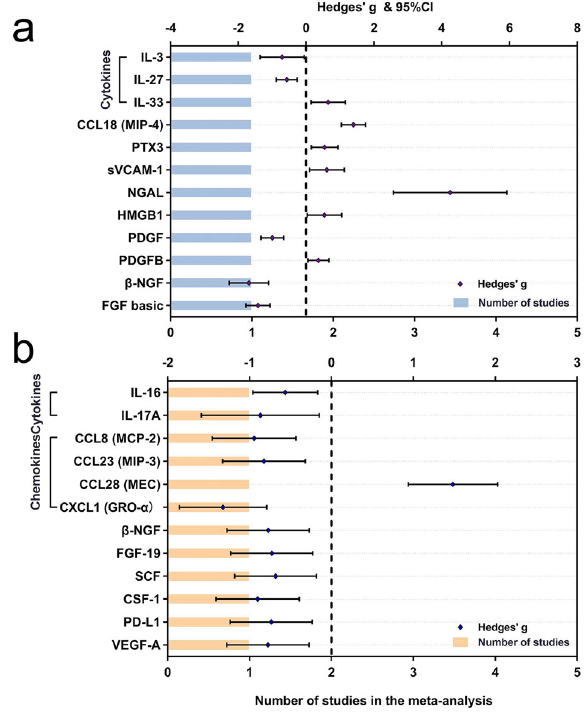
Fig. 3 Comparative outcomes of peripheral blood and cerebrosp- inal fl uid biomarkers in the systematic review. The peripheral blood ( a ) and cerebrospinal fl uid ( b ) in fl ammatory markers with signi fi cant effect sizes (Hedges ’ g) were displayed in comparisons for PD patients versus controls. Violet spots indicate Hedges ’ g of each marker, and blue and orange bars indicate the number of studies included. CCL chemokine (C-C motif) ligand, CSF macrophage- colony stimulating factor, CXCL chemokine (C-X-C motif) ligand, FGF fi broblast growth factor, GRO growth-regulated oncogene, IL interleukin, HMGB high-mobility group box, MCP monocyte chemoattractant protein, MEC mucosae-associated epithelial che- mokine, MIP macrophage in fl ammatory protein, NGAL neutrophil gelatinase-associated lipocalin, NGF nerve growth factor, PD Parkinson ’ s disease, PDGFB platelet-derived growth factor-B, PTX pentraxin, PD-L programmed death-ligand, SCF stem cell factor, SDF stromal cell-derived factor, sVCAM soluble vascular cell adhesion molecule, VEGF-A vascular endothelial growth factor